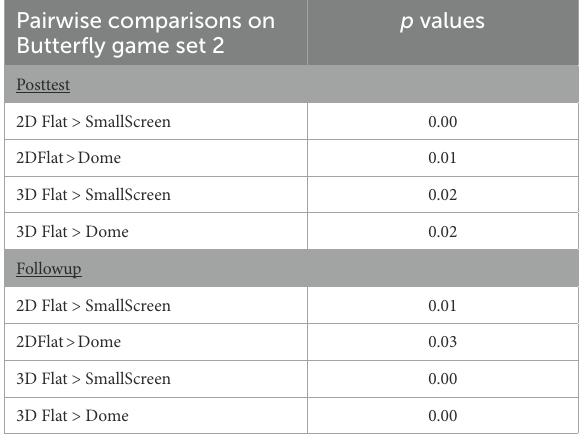
TABLE 10 Conditional pairwise comparisons on the Butterfly gameplay for posttest and followup. Pairwise comparisons on Butterfly game set